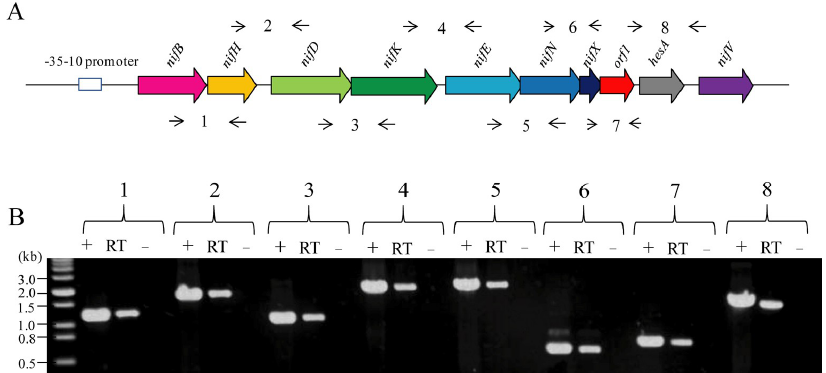
Figure 4. The nif genes of P. graminis RSA19 are organized in an operon as determined by RT-PCR. ( A ) Outline of the strategy. Primers used and amplified products (numbered) are given below the schematic representation of the genes. ( B ) Result of RT-PCR reactions with RNA from P. graminis RSA19 grown under N 2 -fixing conditions. The numbering on the top of the gels corresponds to the product numbers drawn schematically in the outline given above. RT, standard RT-PCR reaction; (−), negative control in which no reverse transcriptase was added to the RT reaction; (+), positive control in which genomic DNA was used as template in the RT-PCR.